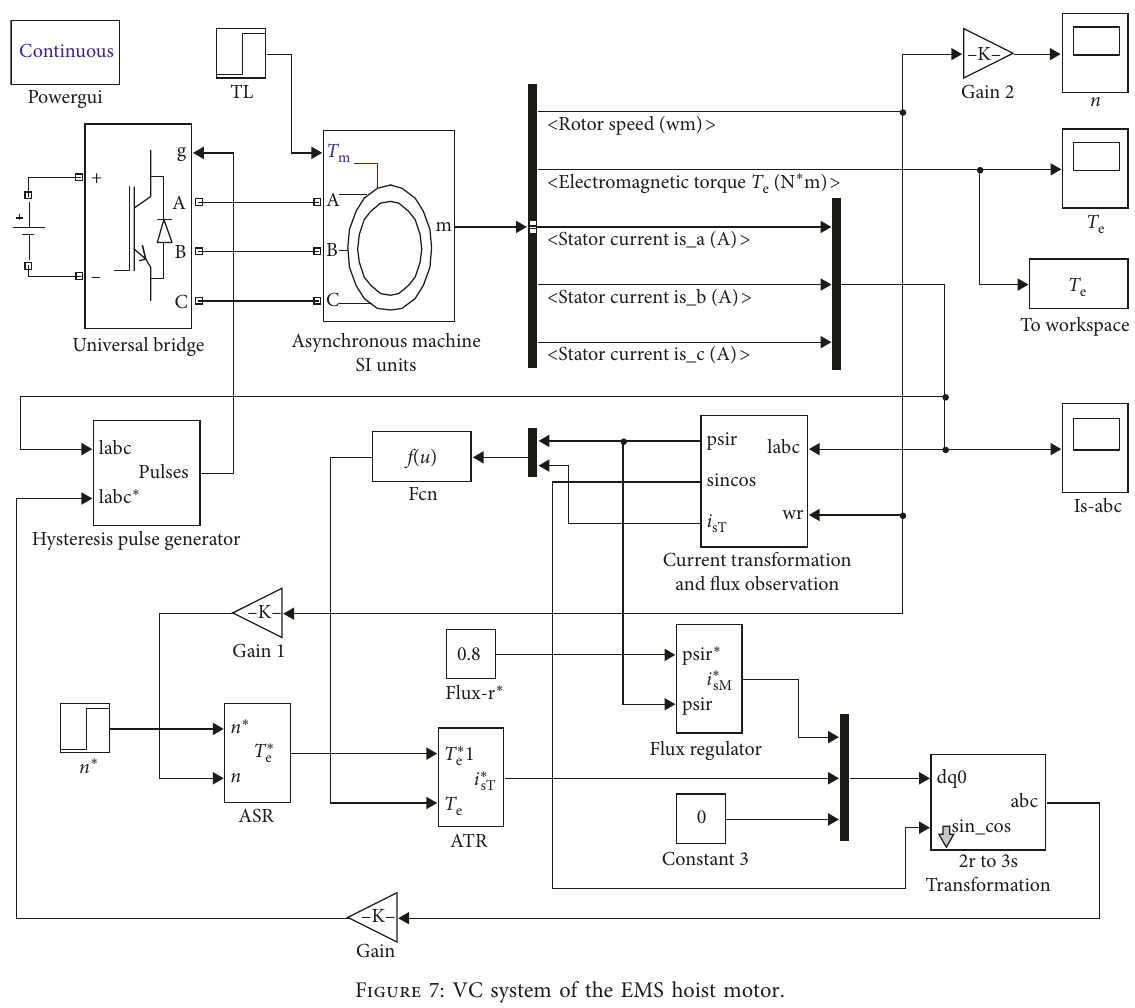
Figure 7: VC system of the EMS hoist motor.